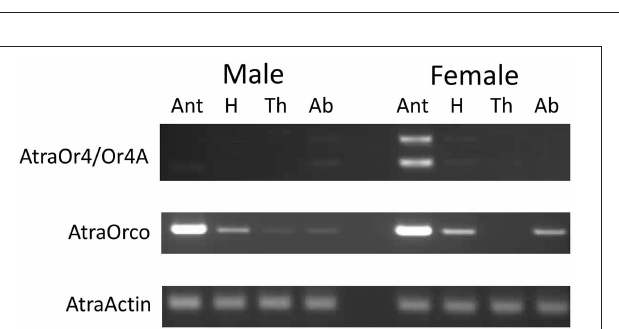
FIGURE 3 | Partial genomic DNA sequence encoding 3 ′ end of AtraOR4 and alignment of AtraOR4 and AtraOR4A transcripts. AtraOR4 genomic DNA sequence is in black, AtraOR4A is in red, and AtraOR4 is in blue. Putative splice sites are for excision and insertion.